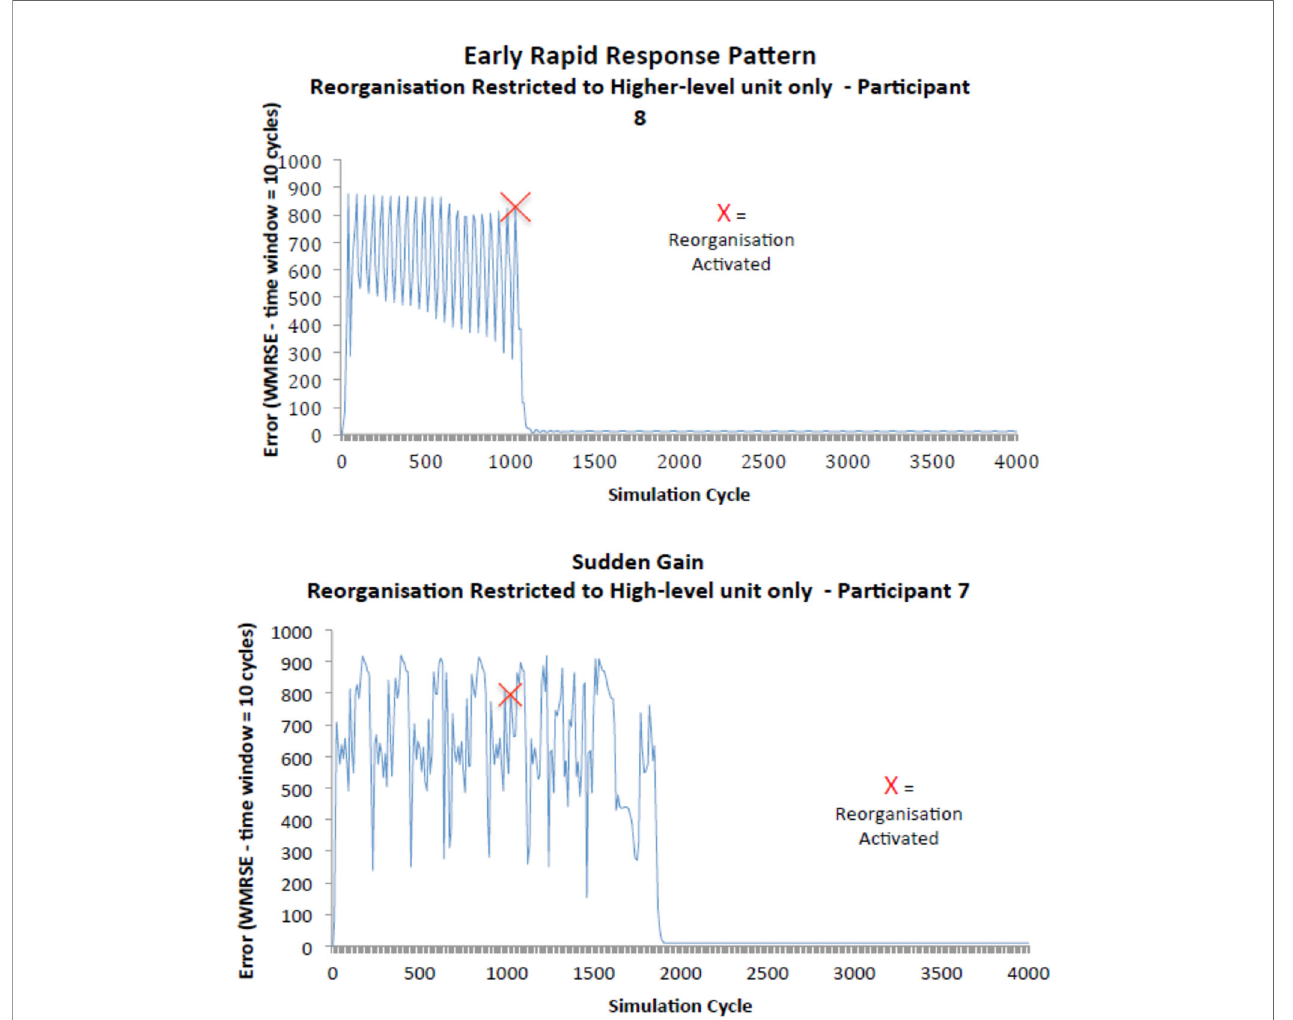
FIGURE 4 | Graphs of change in overall error during the simulation in individual agents. The fi rst pattern resembles the early response pattern found in patients, and the second pattern resembles sudden gains during therapy (77). WMRSE is the Window Mean Root Squared Error. To calculate WMRSE, the squared error terms across all control units are averaged over ten iteration cycles of the simulation, and then the square root of this fi gure is